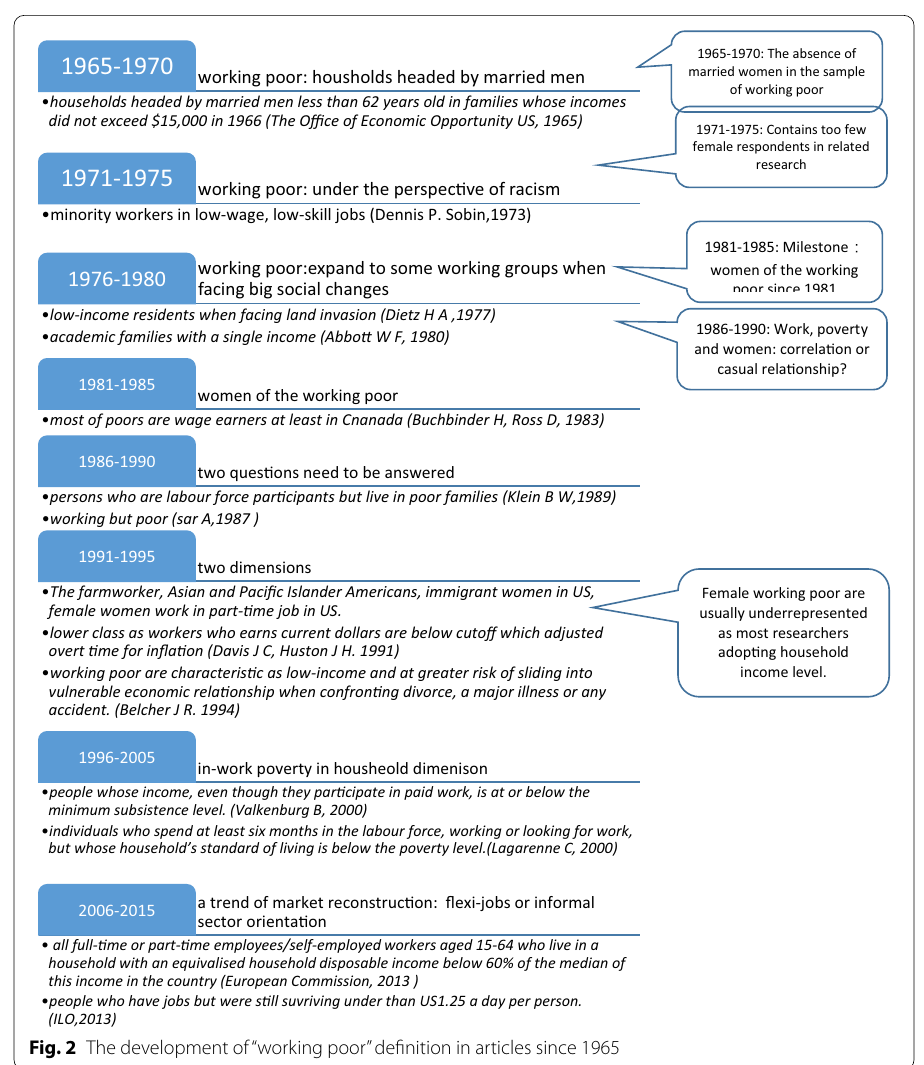
Fig. 2 The development of “working poor” definition in articles since